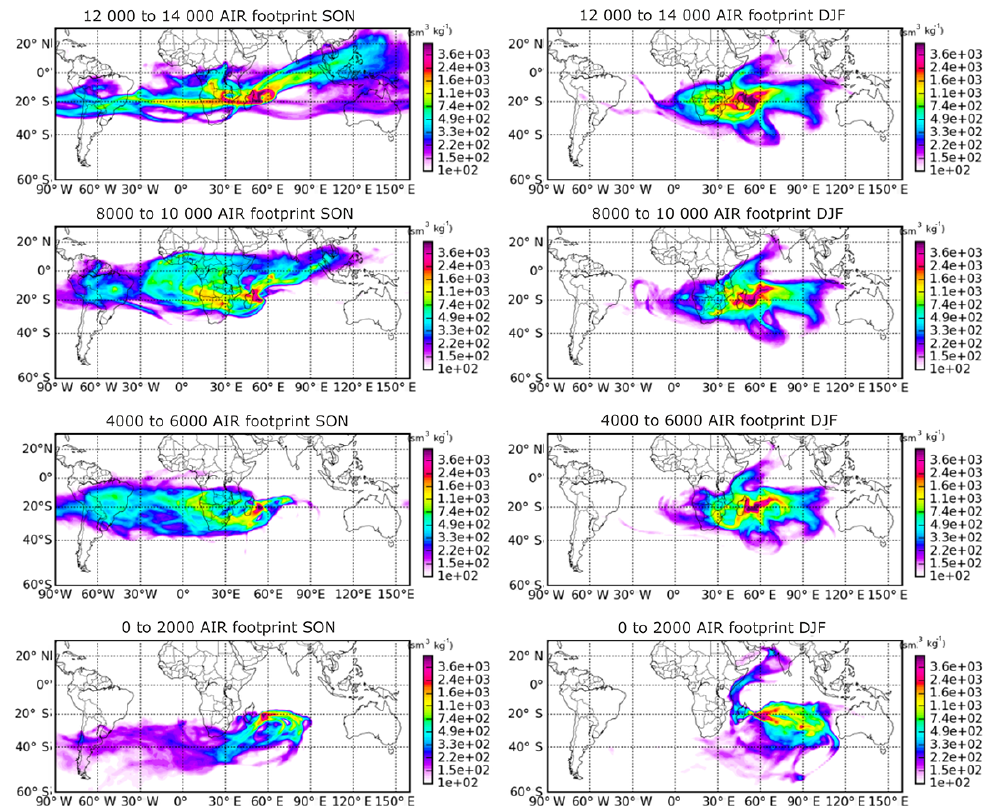
Figure A1. Seasonal distributions of the emission response sensitivity in backward simulations of the air at four vertical ranges (0–2000, 4000–6000, 8000–10000 and 12000–14000ma.s.l.) in the troposphere above Reunion Island in the 2011–2013 period simulated with